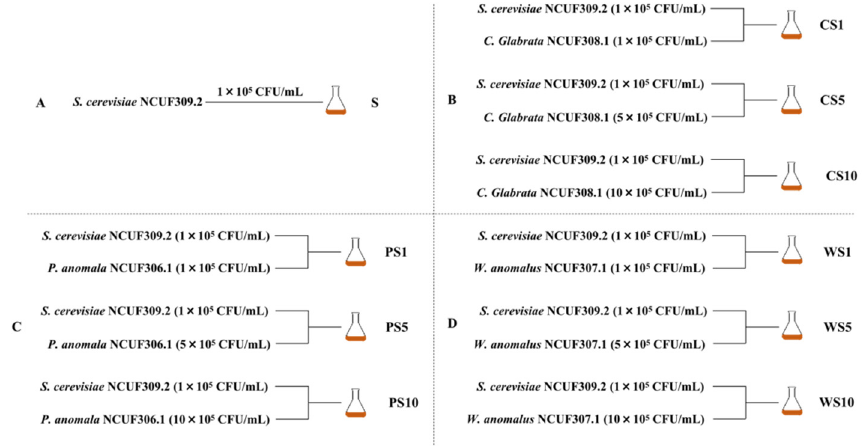
Figure 1. Fermentation conditions of pure fermentation of S. cerevisiae NCUF309.2 and co-fermentation of ester-producing yeasts and S. cerevisiae NCUF309.2 under different ratios. ( A ) pure fermentation of S. cerevisiae NCUF309.2; ( B ) co-fermentation of C. glabrata NCUF308.1 and S. cerevisiae NCUF309.2; ( C ) co-fermentation of P. anomala NCUF306.1 and S. cerevisiae NCUF309.2; ( D ) co-fermentation of W. anomalus NCUF307.1 and S. cerevisiae NCUF309.2.